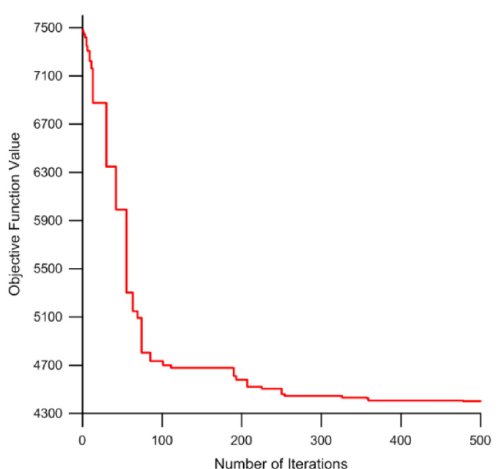
Fig. 7. Convergence history for the planar 18-bar truss using